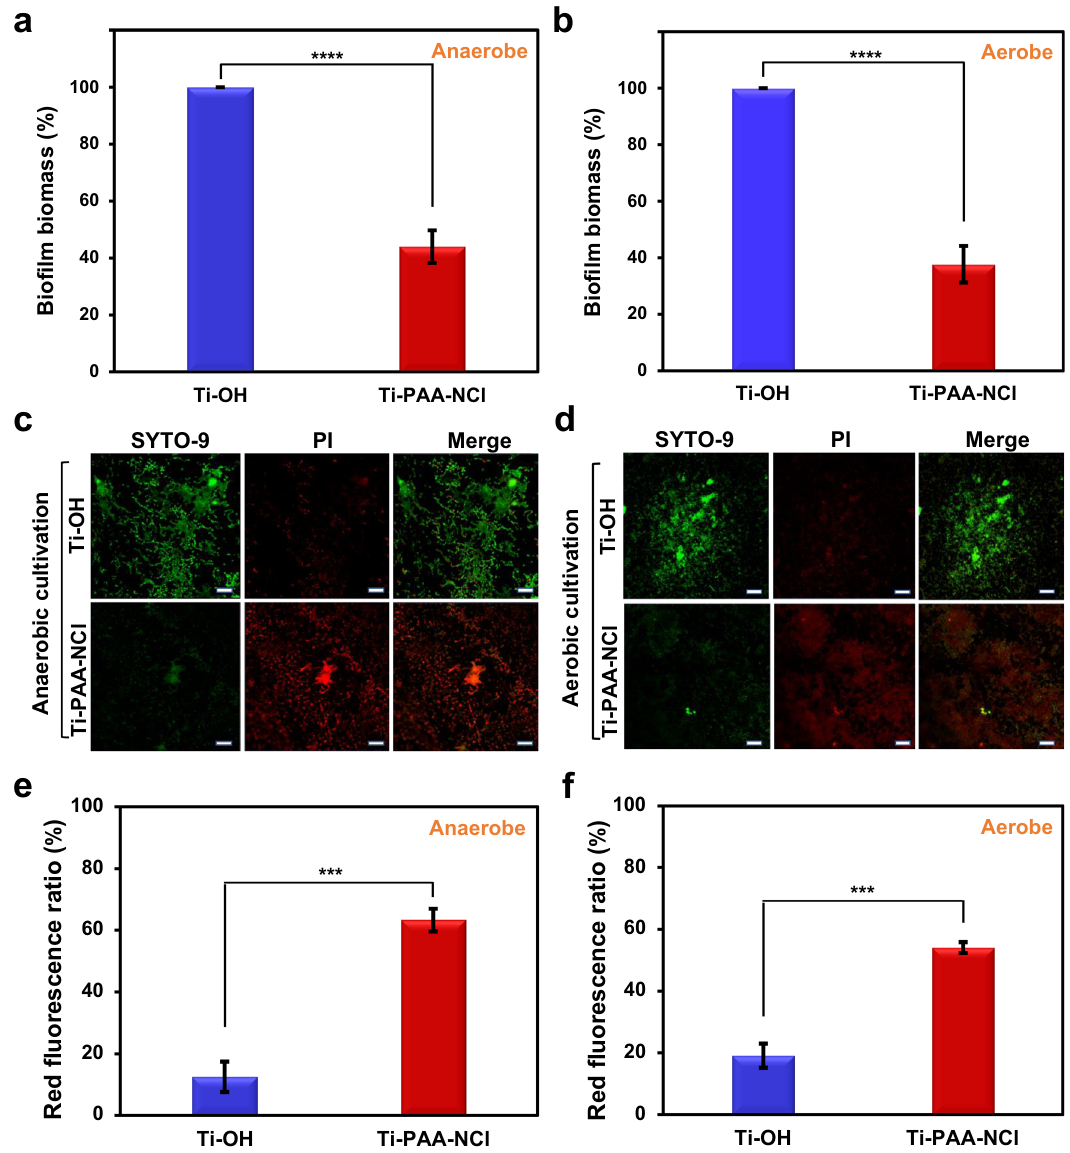
Fig. 4 Antibacterial effect on complex bacteria from patients with peri-implantitis after 24 h incubation. The amount of bio fi lm biomass shown as a percentage of that formed on Ti-OH under a anaerobic and b aerobic cultivation evaluated by crystal violet staining ( n = 10). Fluorescent staining illustrating the live/dead distribution of c anaerobic bacteria and d aerobic bacteria (green for live cells, red for dead cells; scale bars = 20 μ m). Quantitative analysis of the live/dead staining results for e anaerobic and f aerobic bacteria ( n = 3). *** P < 0.001, **** P < 0.0001; Student ’ s t test; all error bars =